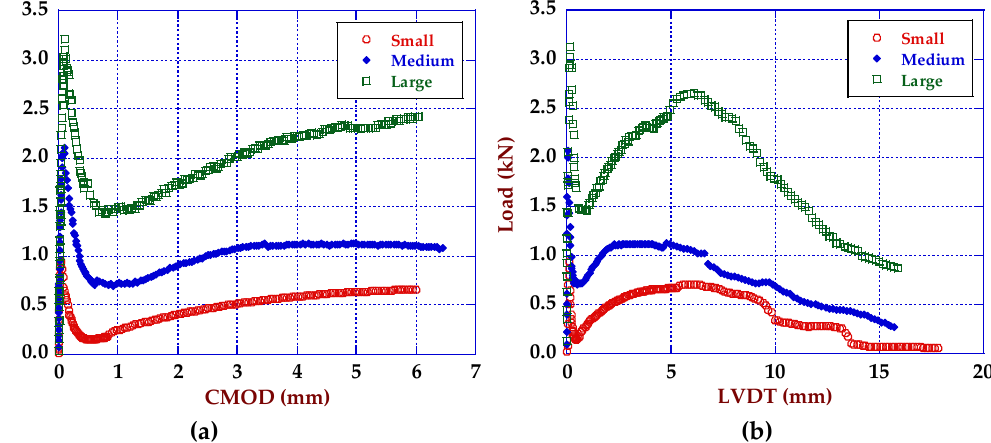
Figure 7. Average fracture curves for the three specimen sizes: ( a ) load-crack mouth opening displacement (CMOD) plots; ( b ) load-mid-span deflection (LVDT).